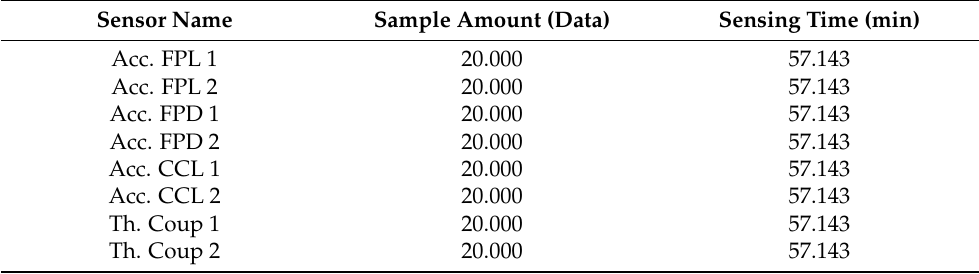
Table 4. Sampling data amount on each sensor.